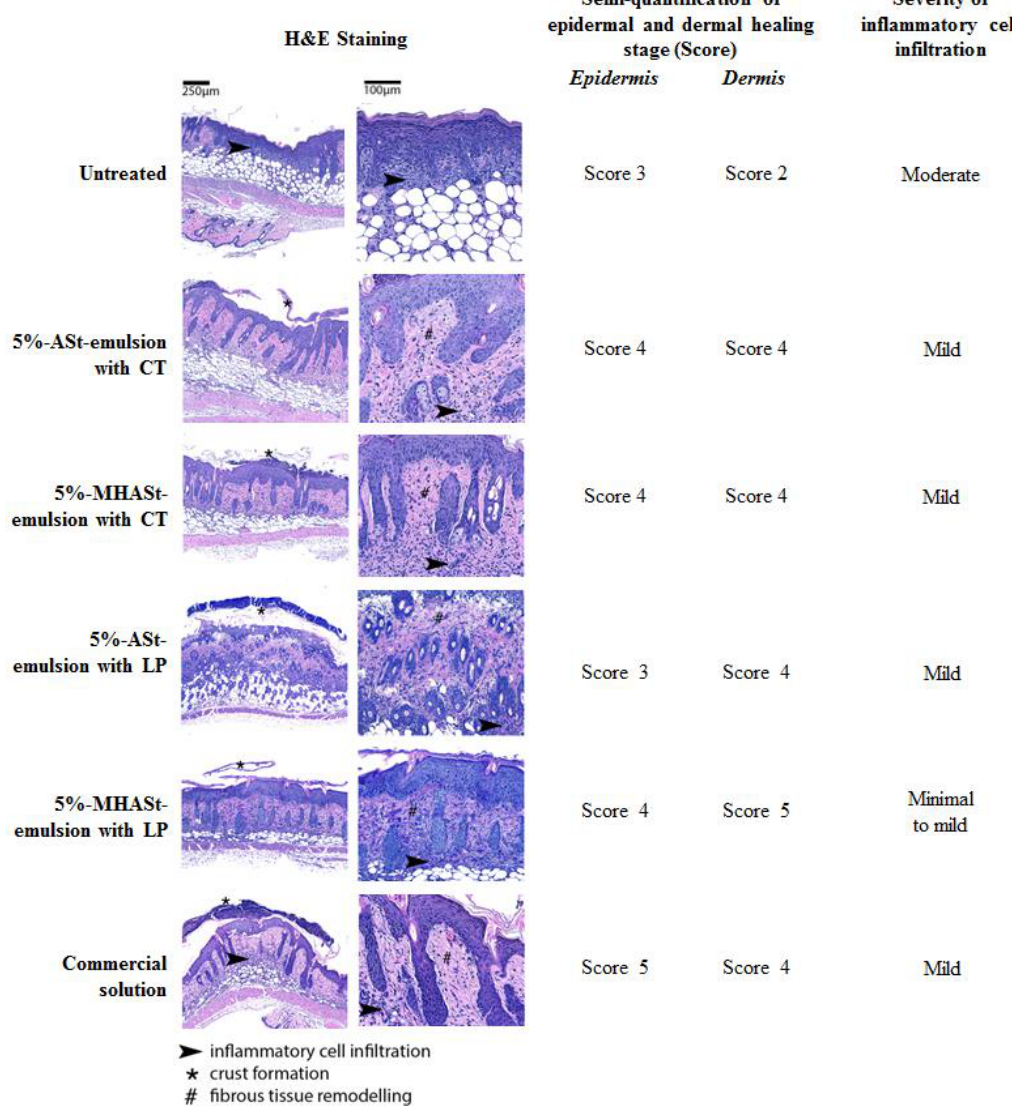
Figure 6. Hematoxylin and eosin-stained sections of tape-stripping lesions in BALB/c mice. Experimental groups included: untreated; 5%-ASt-emulsion with CT; 5%-MHASt-emulsion with CT; 5%-ASt-emulsion with LP; 5%-MHASt-emulsion with LP; Commercial solution; all previously preceded by epicutaneous bacterial infection.